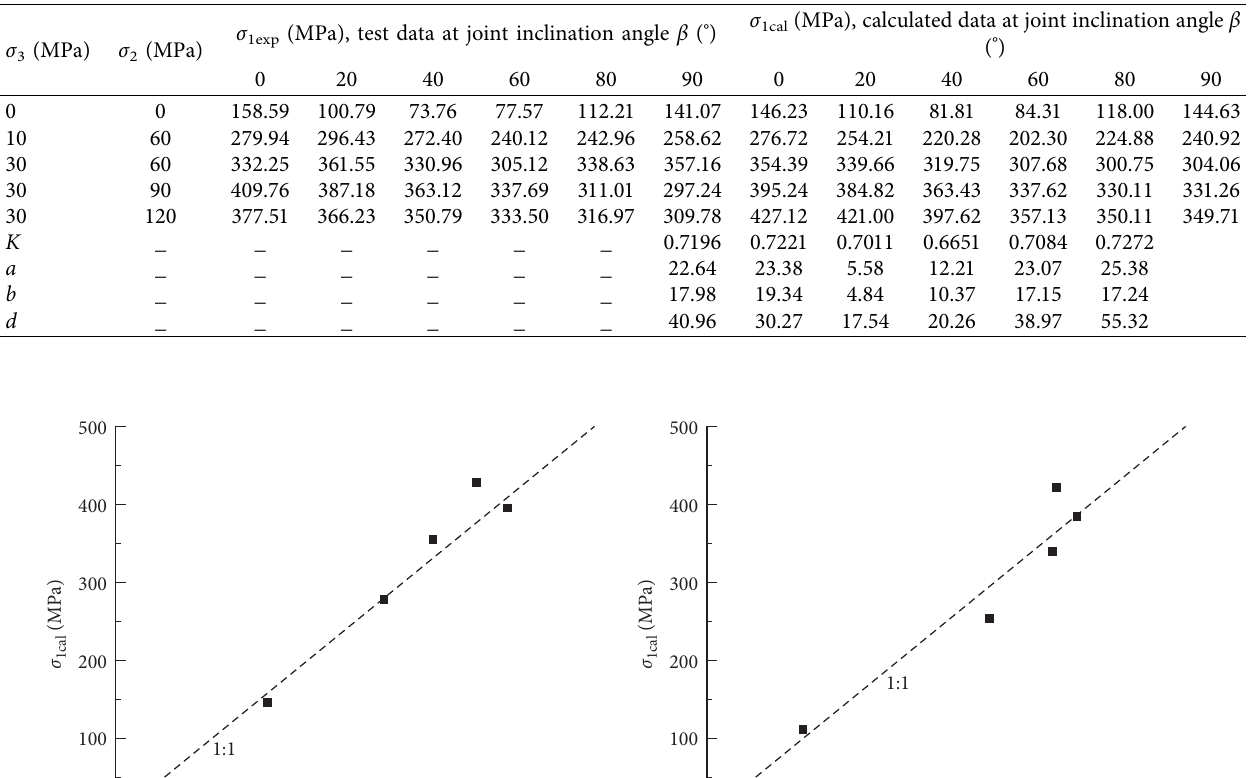
Table 1: True triaxial compression strength of experimental and predicted results of jointed marble (data from [9]; here, compressive stress is considered